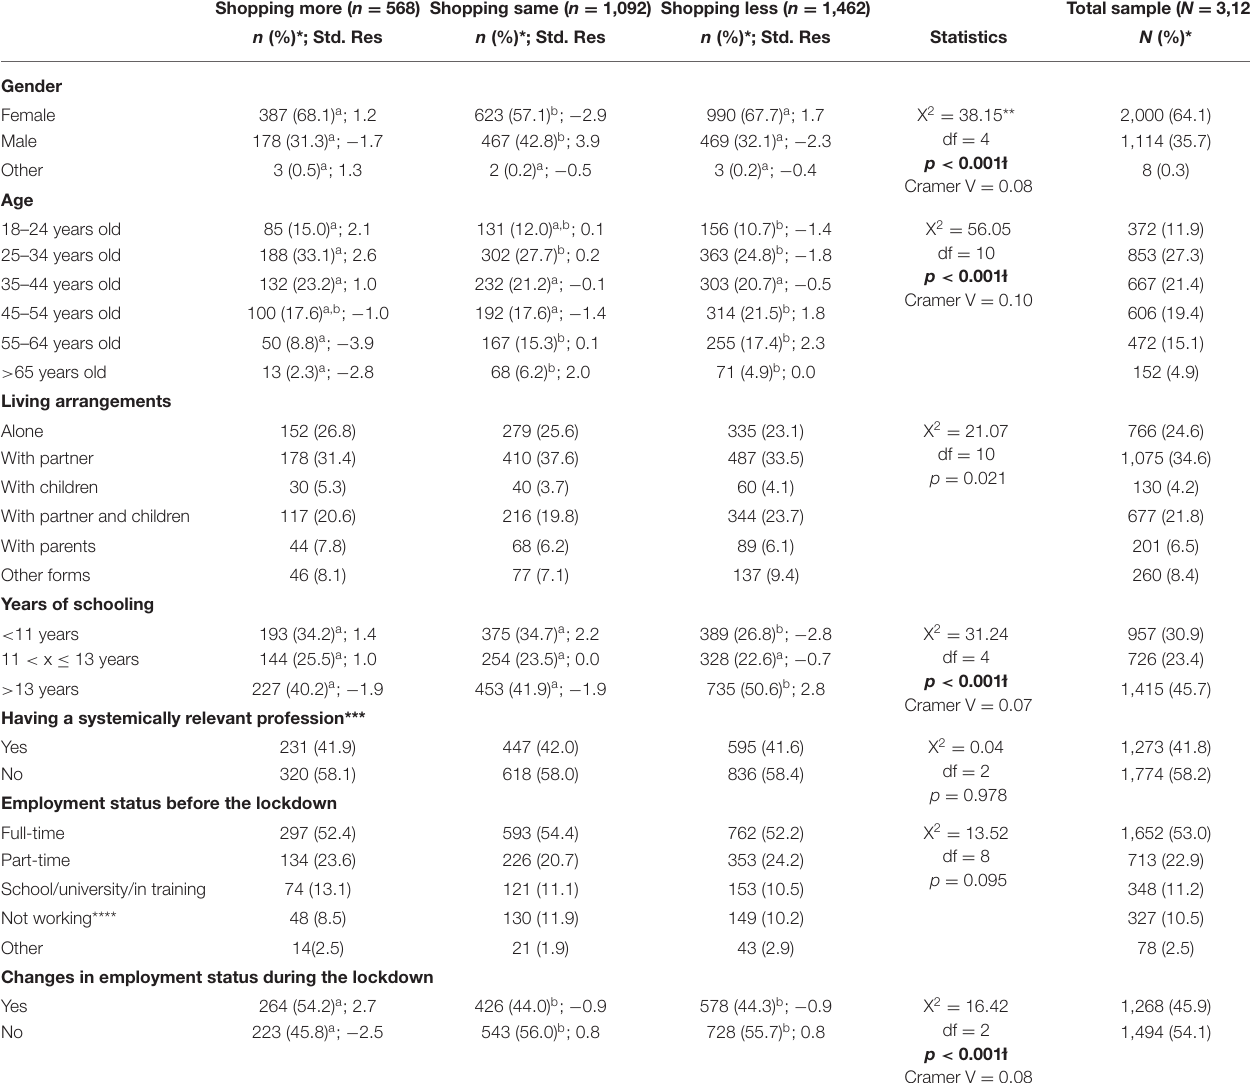
TABLE 1 | Sociodemographic description of the total sample and group